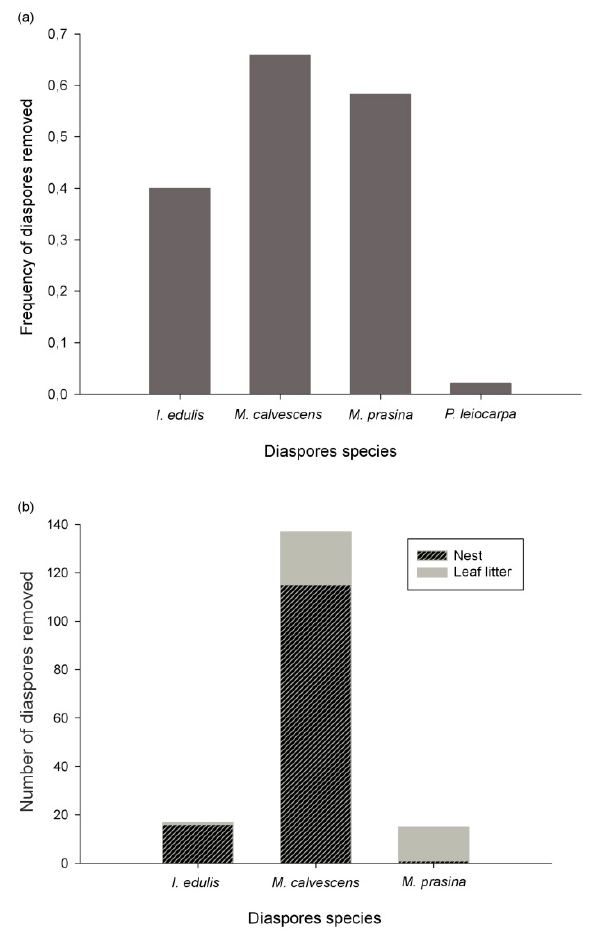
Fig 2 . (a) Diaspores removal frequency of the plant species studied. (b) Destination of diaspore removals (nest = black hatched bar, litter = grey